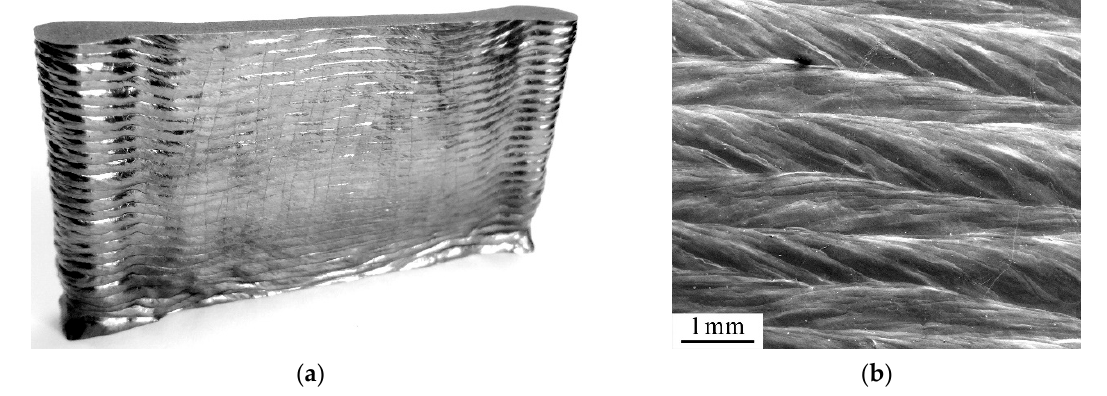
Figure 2. Image ( а ) and surface profile ( b ) of a Ti–6Al–4V sample deposited by the Electron beam free-form fabrication EBF 3 process.